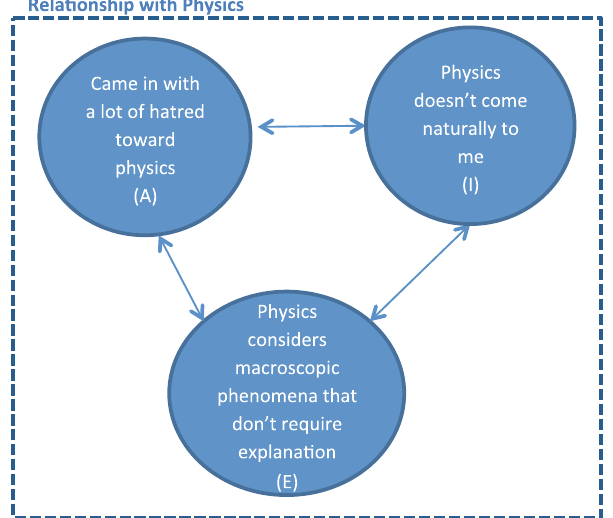
FIG. 3. A representation of Violet ’ s early relationship with physics as demonstrated by clips 1 and